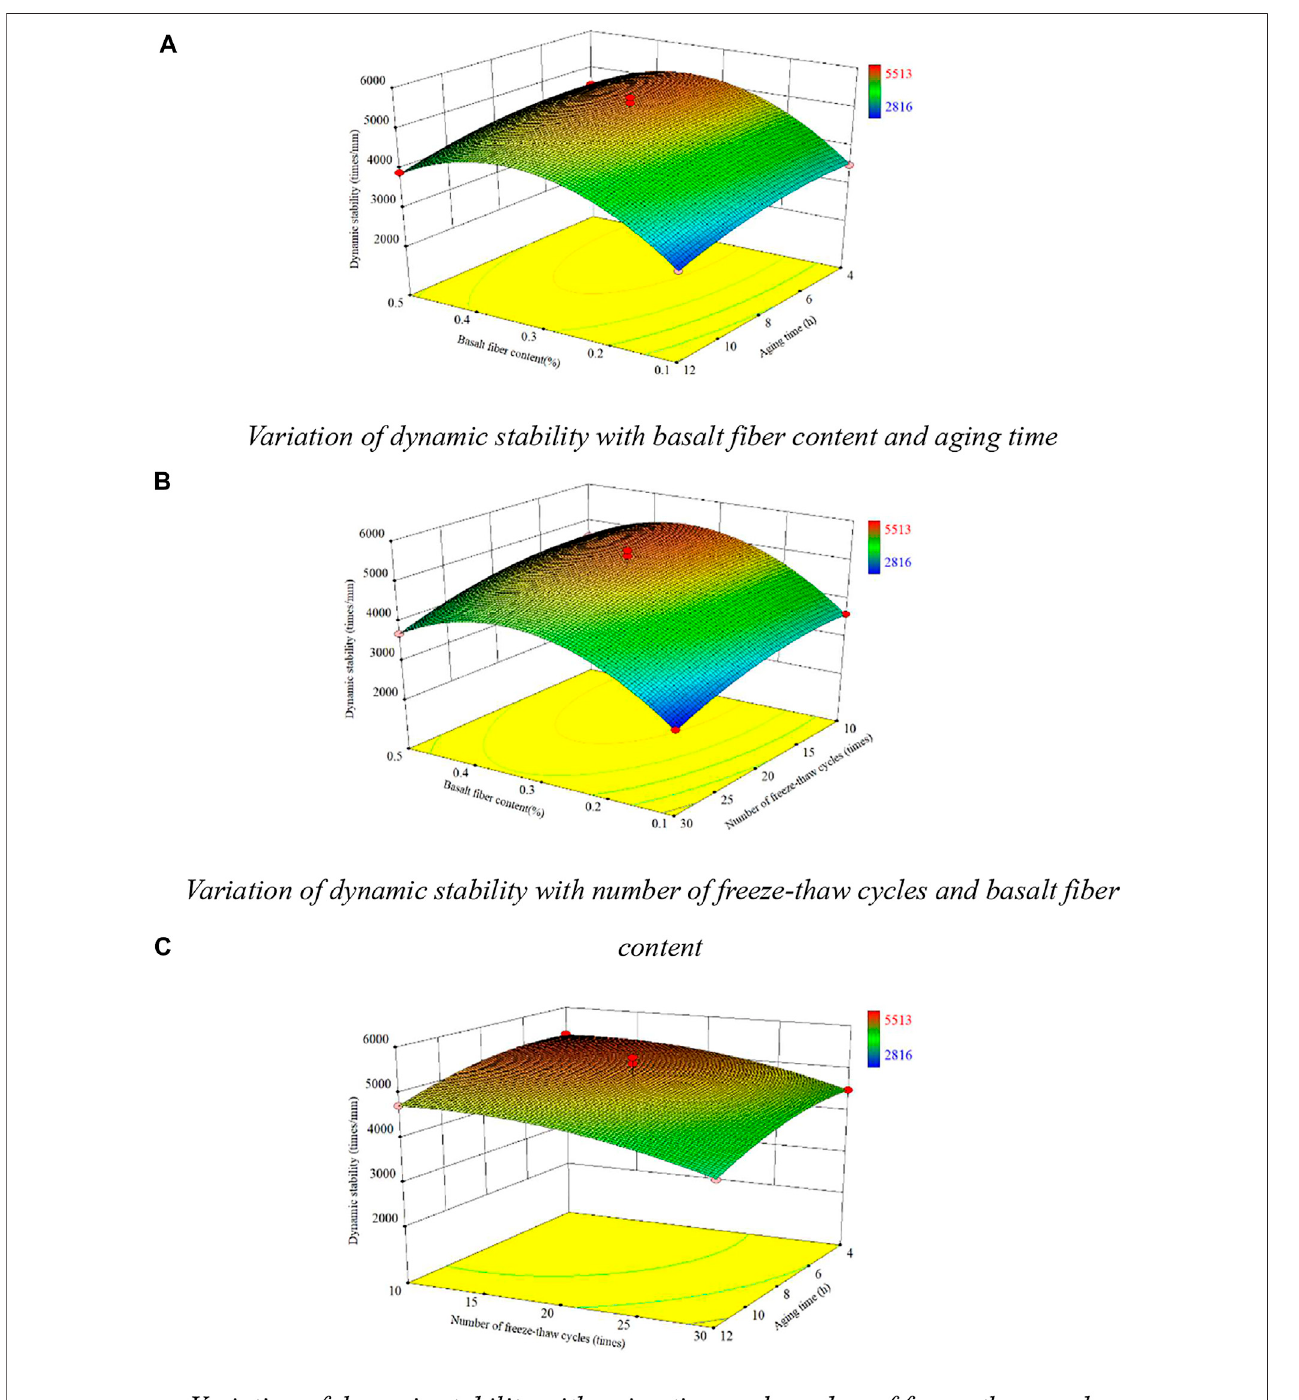
FIGURE 4 | Test result of dynamic stability. (A) Variation of dynamic stability with the basalt fi ber content and aging time. (B) Variation of dynamic stability with the number of freeze-thaw cycles and basalt fi ber content. (C) Variation of dynamic stability with aging time and the number of freeze-thaw cycles.